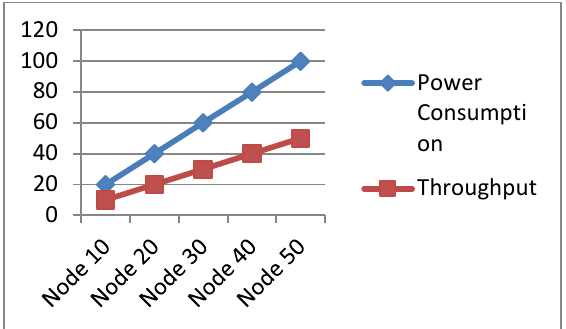
Figure 5. Packet Delivery Ratio